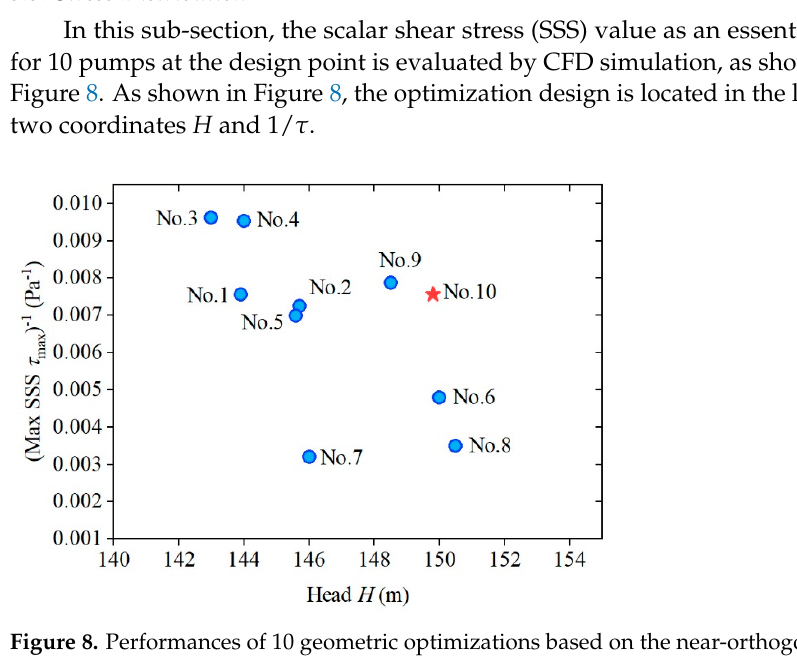
Figure 8. Performances of 10 geometric optimizations based on the near-orthogonal array.The blue solid circles represent the 9 different designs while the red star represents the optimization design.